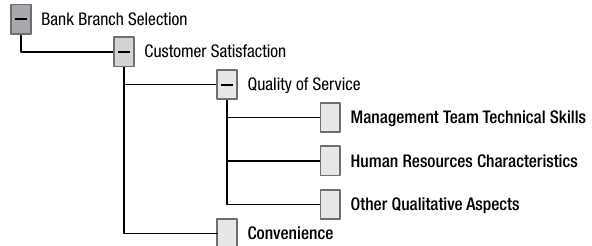
Fig. 3. Service quality and convenience performance measures